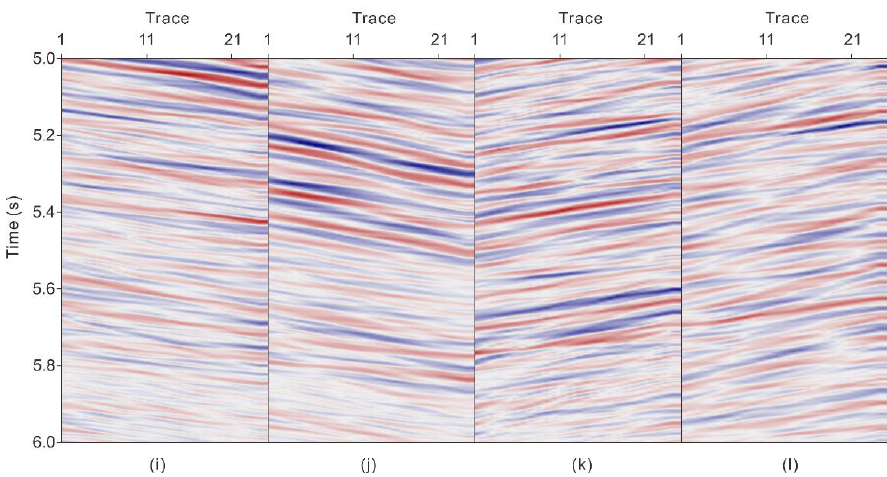
Figure 15. Results for the separation of the VSP wavefield. ( a , e , i ) Downgoing P-wave; ( b , f , j ) Downgoing S-wave; ( c , g , k ) Upgoing P-wave; ( d , h , l ) Upgoing S-wave; ( a – d ) Results for our method; ( e – h ) Results for traditional median filtering; ( i – l ) Results for the high-resolution Radon transform method.